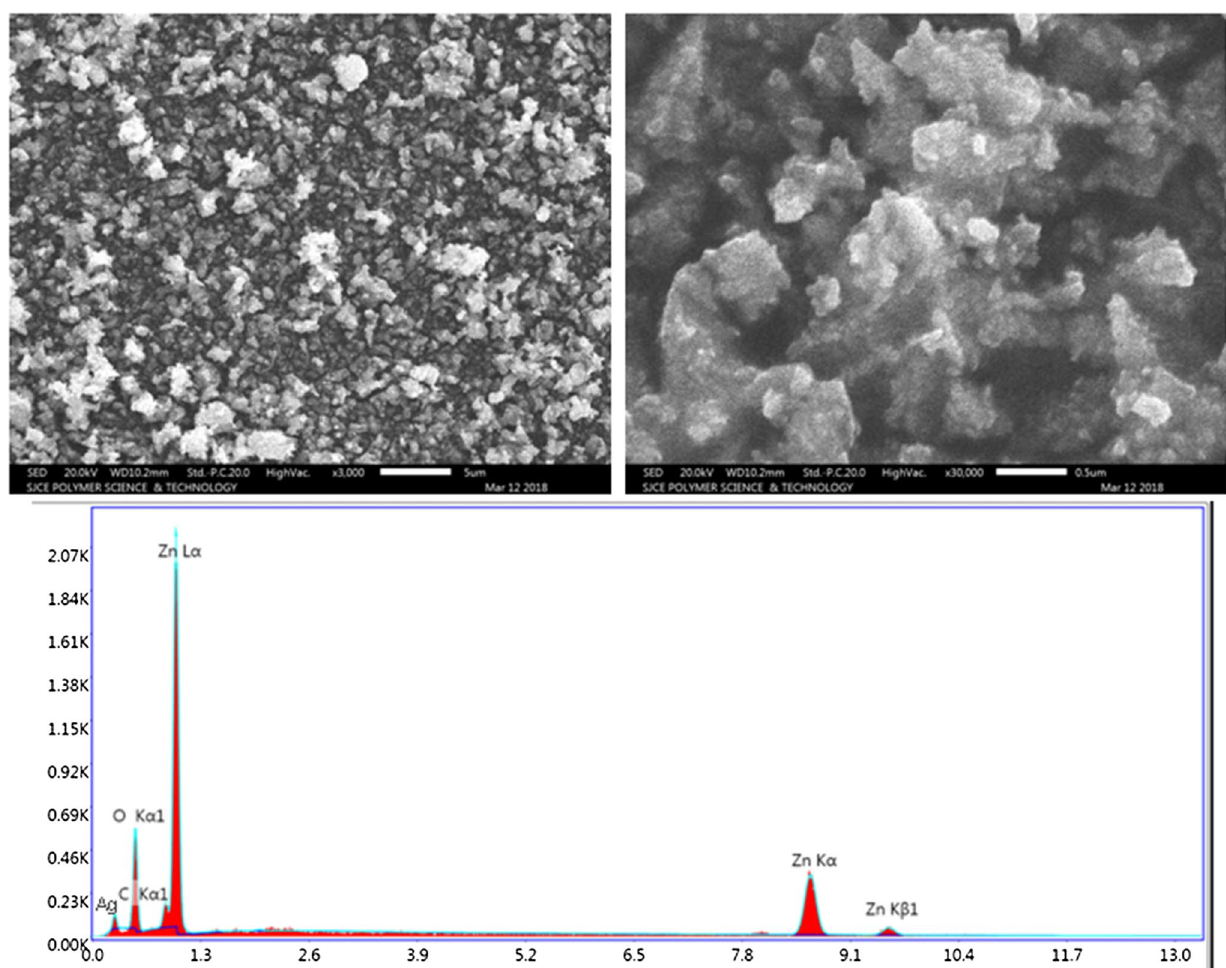
Fig. 3 Scanning electron microscopic images with energy-dispersive X-ray analysis of Ag/ZnO